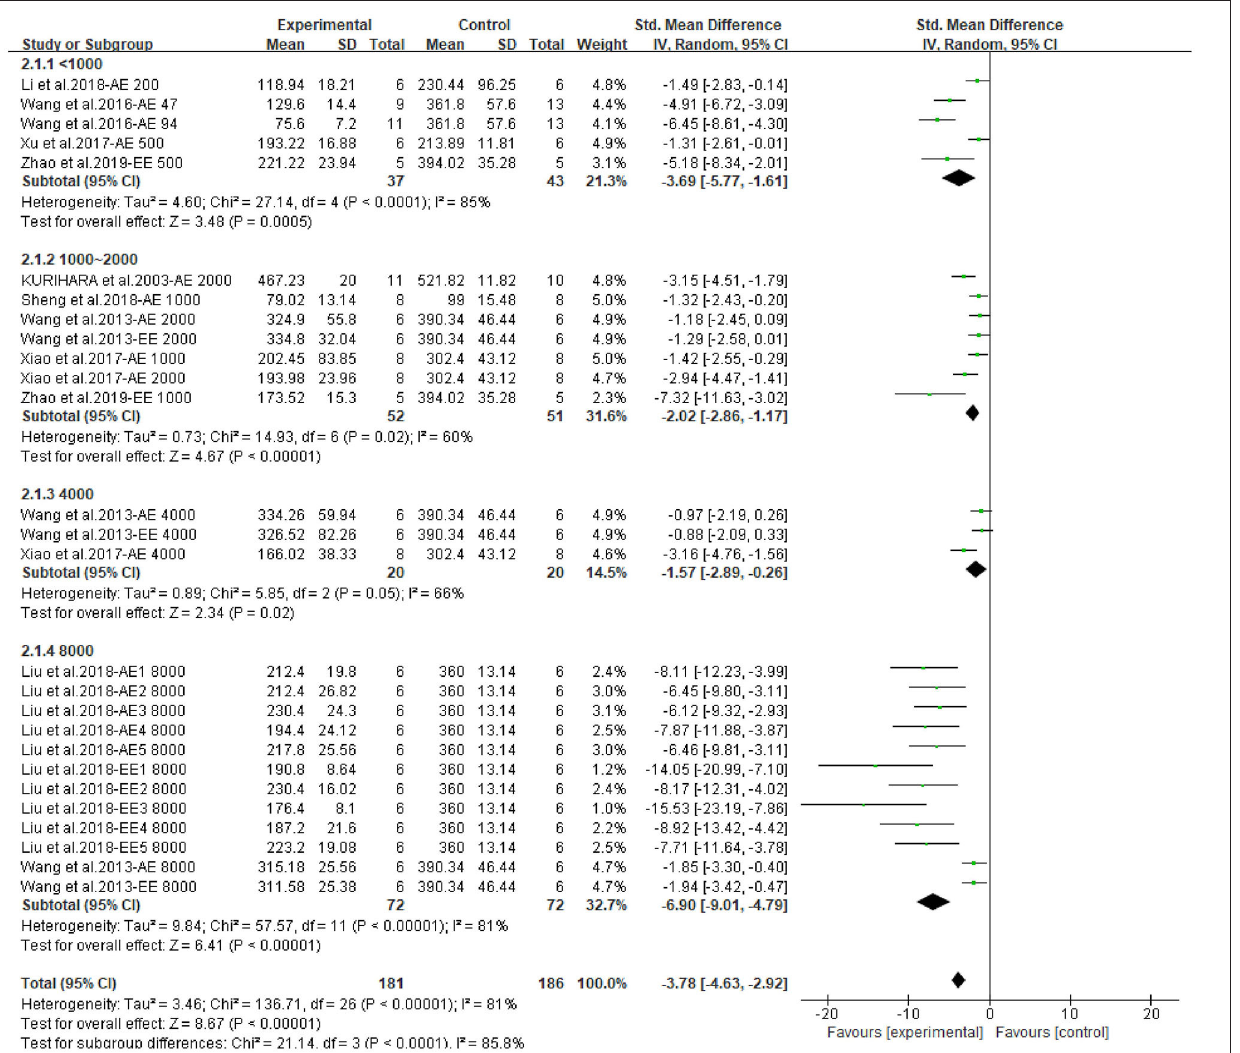
FIGURE 3 | Forest plot for the effect of Cyclocarya paliurus (CP) on blood glucose levels in animal models. Subgroup analysis was performed according to doses.